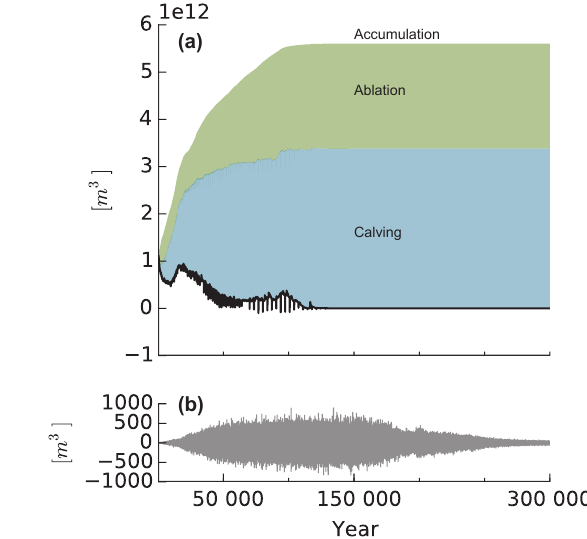
Figure 5. (a) Integrated mass balance as a function of time for the Northern Hemisphere domain. The upper panel shows the total ac- cumulation integrated over the entire domain (upper boundary of colored area) as well as the effect of ablation (green) and calving (blue). The lower boundary of the colored area is the sum of all three components, i.e., the estimate of the net integrated mass bal- ance. The solid black line represents net changes in total ice volume as diagnosed from the model directly. (b) Difference between the sum of contributions and the true change in ice volume in the model, which is at least 10 orders of magnitude smaller than the calculated